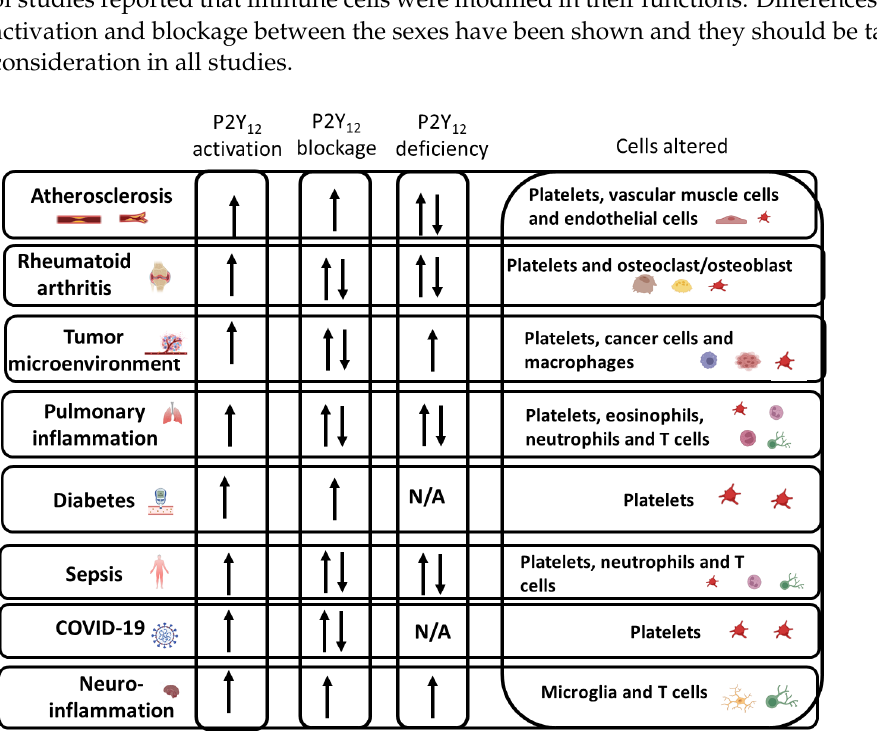
Figure 3. A schematic representation of how P2Y 12 activation, blockage, and deficiency are altered in inflammatory conditions and a list of which cells appear to be affected. Overall, P2Y 12 did appear to be activated in all the inflammatory conditions reported in the graph. However, it is still unclear whether blockage or deficiency could consistently improve the outcome. The arrow pointing top and down represents an increase and decrease respectively. Cells with both arrows shows inconsistency.